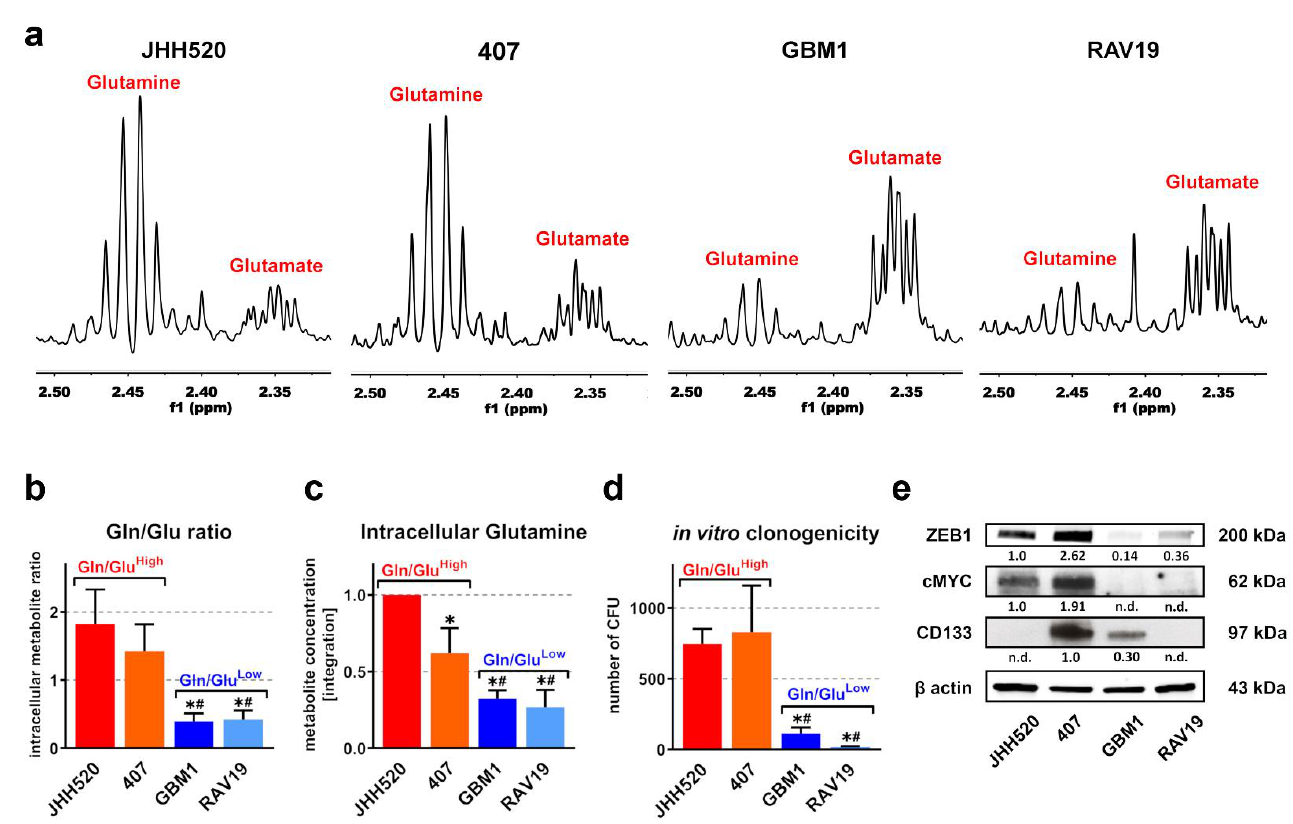
Figure 1. High Gln/Glu ratios predicted for in vitro clonogenicity in glioblastoma stem-like cells (GSCs). ( a ) Expanded regions from 1 H-NMR spectra showing Gln and Glu multiplets and ( b ) corresponding Gln/Glu ratios of metabolic extracts from untreated JHH520, 407, GBM1, and RAV19 GSC cultures ( n ≥ 6). ( c ) Relative intracellular Gln concentrations were assessed with 1 H-NMR spectroscopy ( n = 3). ( d ) The baseline soft agar colony formation capacity (in vitro clonogenicity) of untreated GSC cultures showed correlation with high Gln/Glu ratios ( n = 9). ( e ) Immunoblotting of baseline ZEB1, CD133, and cMYC protein showed elevated ZEB1 and cMYC in GSCs with high Gln/Glu ratios (JHH520 and 407) (loading control = β actin). For all assays, the data are presented as mean ± SD. Significance was calculated with a one-way ANOVA, * significantly decreased ( p < 0.05) compared to JHH520, # significantly decreased ( p < 0.05) compared to 407. Abbreviations: Gln, glutamine; Glu, glutamate; n.d., not detectable; ppm, parts per million. Supplementary Figure 1 (S1) corresponds to Figure